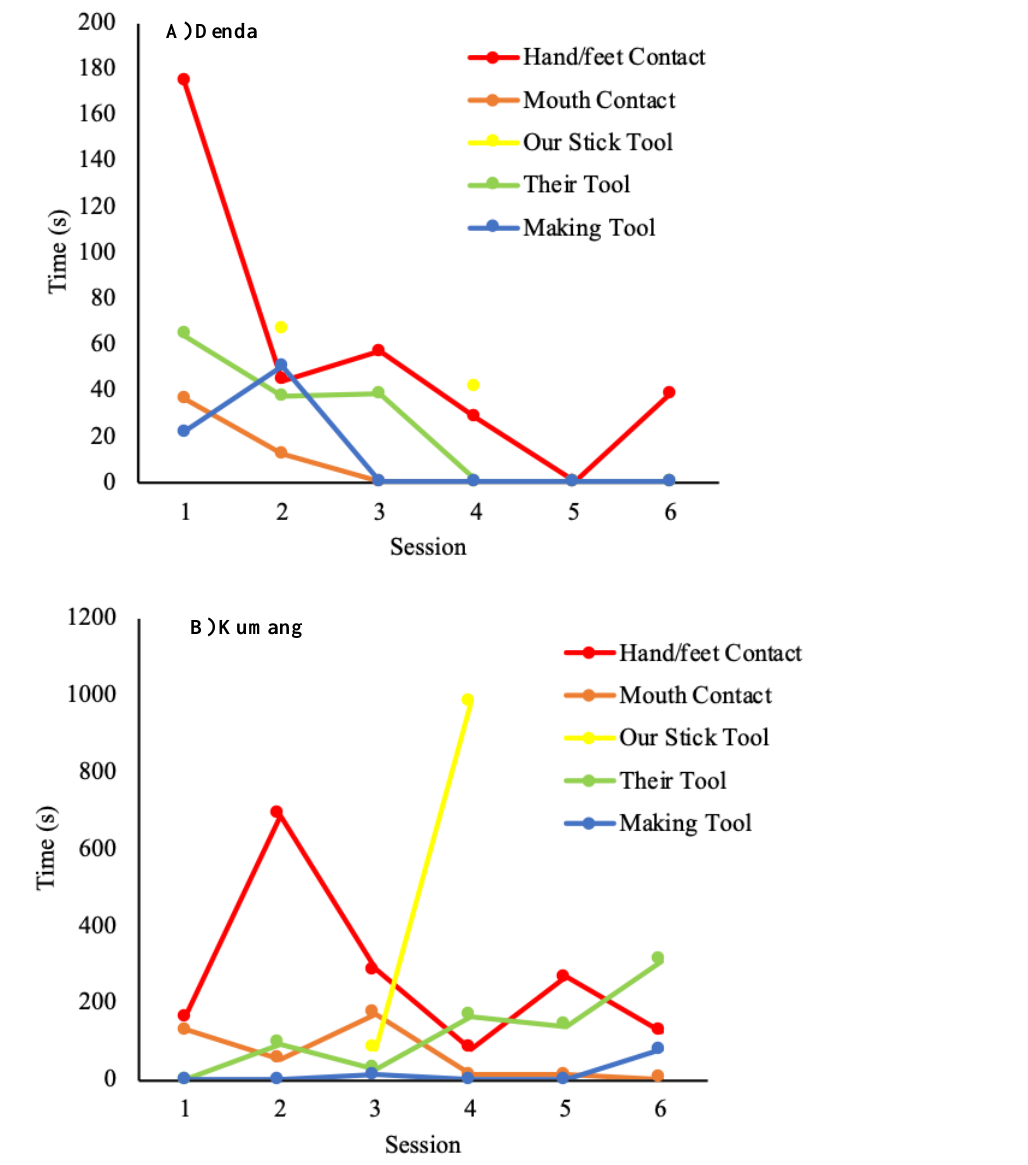
Time Spent Engaged in Different Behaviors in the Test